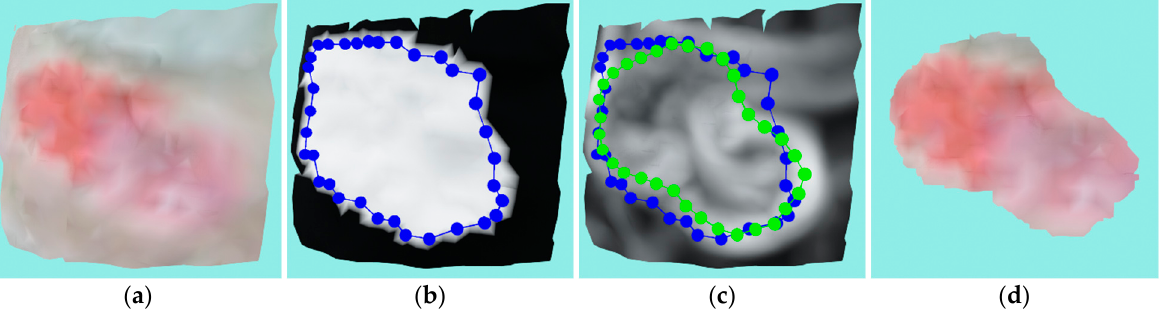
Figure 21. Case study for a smaller venous ulcer: ( a ) input wound mesh; ( b ) masked wound mesh with initial contour; ( c ) wound mesh with curvature texture and initial and final contours shown in blue and green colors, respectively; ( d ) final cut wound mesh model.